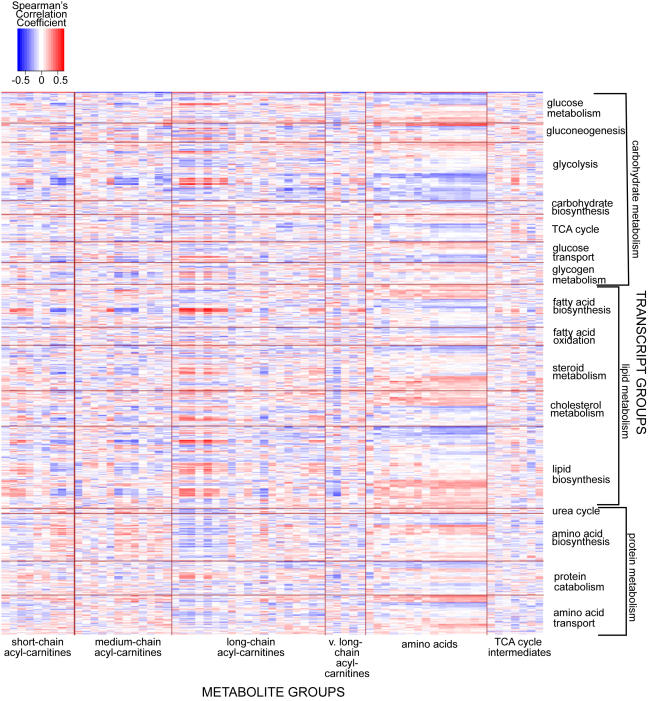
Heat map of correlations between liver metabolites and select liver transcripts.Each square represents the Spearman's correlation coefficient between the metabolite of the column with the transcript of the row (|r|>0.254, p<0.05; |r|>0.330, p<0.01). Metabolites are organized into their biochemical class; transcripts are selected based on gene ontology terms relating to biological processes in which they play a role. Correlation coefficients between individual amino acids with select transcripts are found in Table S3.